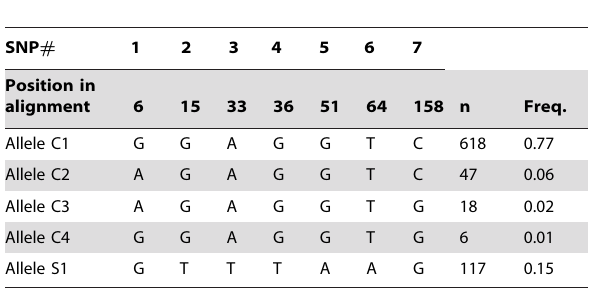
Table 2. Different Nv- nfkb alleles and their allele frequencies.